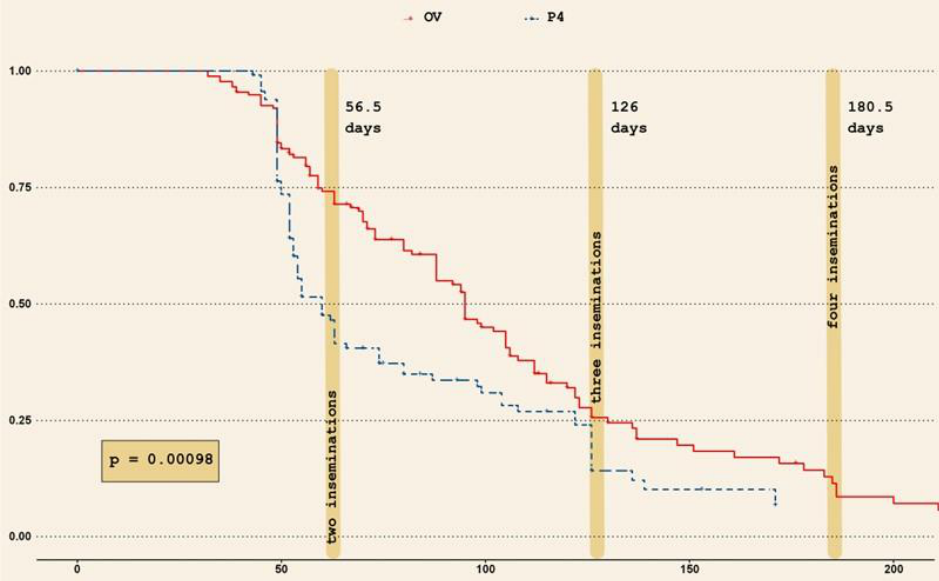
Figure 5. Survival curves showing the effect of treatments and interval from parturition on pregnancy rates, following consecutive re-synchronization protocols after the first artificial insemination (AI) in primiparous buffaloes. Solid line refers to Ovsynch (OV) and dashed curve to Progesterone based treatment (P 4 ) ( p = 0.00098). The vertical stripes depict the median number of days to become pregnant at the second, third and fourth AI.